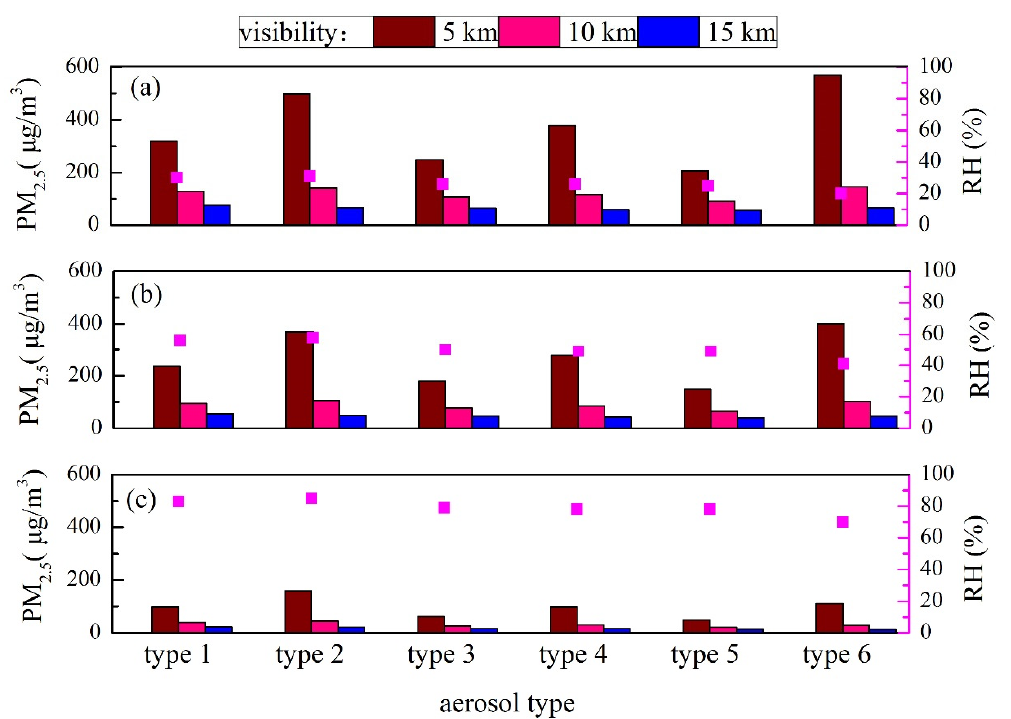
Figure 8. PM 2.5 (the histogram) and RH (the pink scatter) threshold values of visibility-sensitive re-